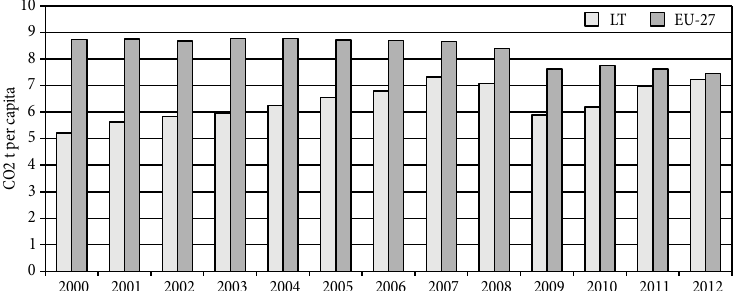
Fig. 2. Annual changes in CO2 equivalent emissions per capita from the total economic activity in Lithuania, compared with the mean change of the EU-27 member states